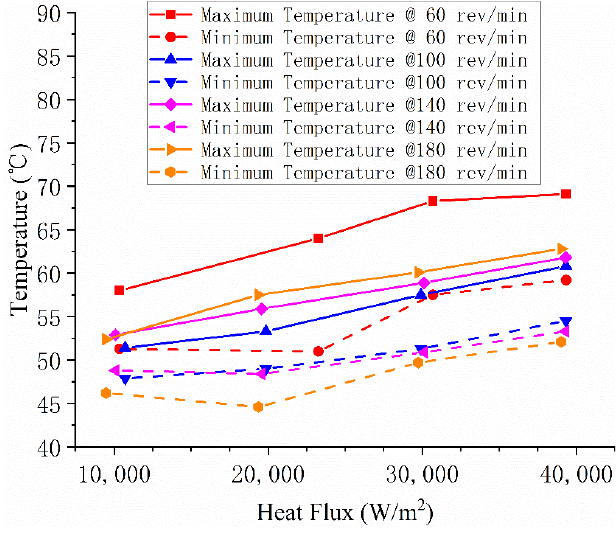
Figure 8. Change of temperature extremums with revolving speed and heat flux.